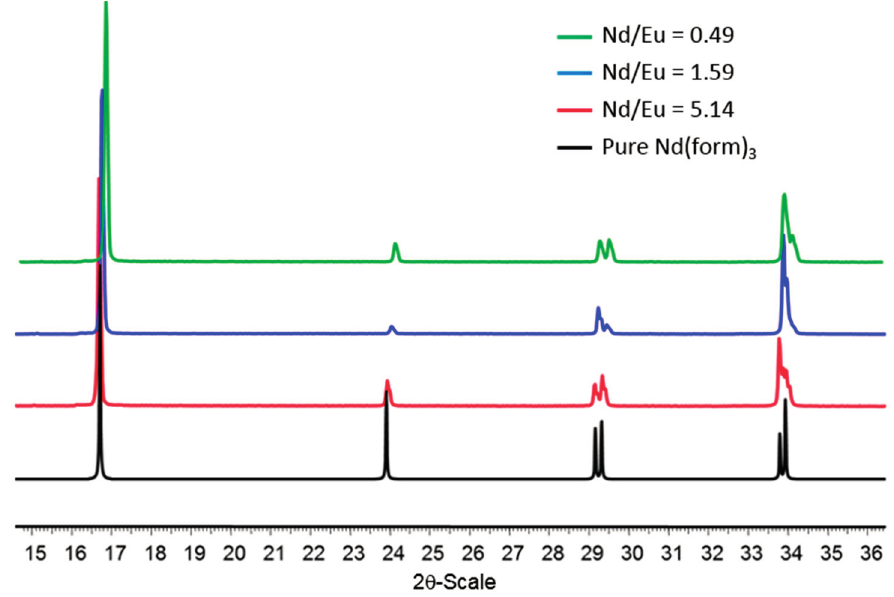
Figure 3. The PXRD pattern of the Nd(form) 3 MOF and the three MOFs with varying Nd/Eu ratios.